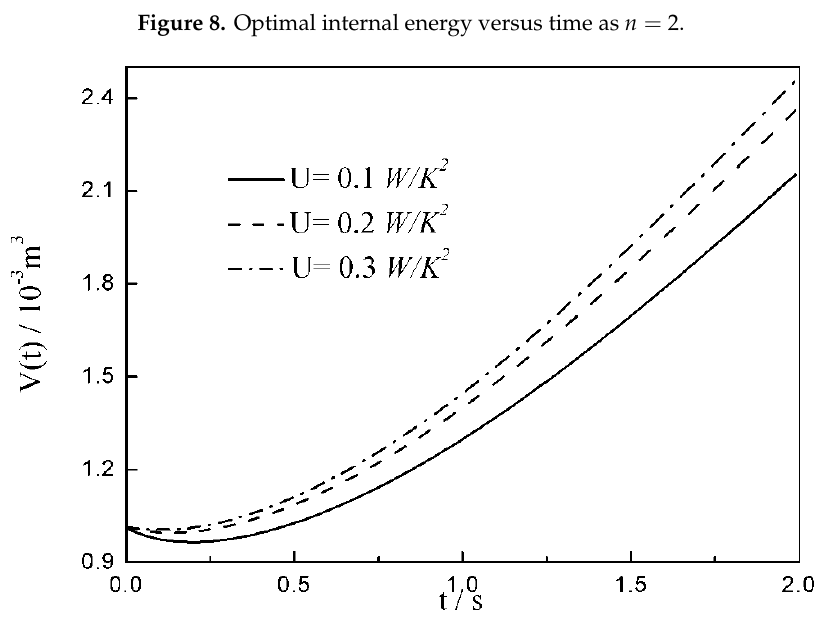
Figure 9. Optimal volume versus time as n = 2.